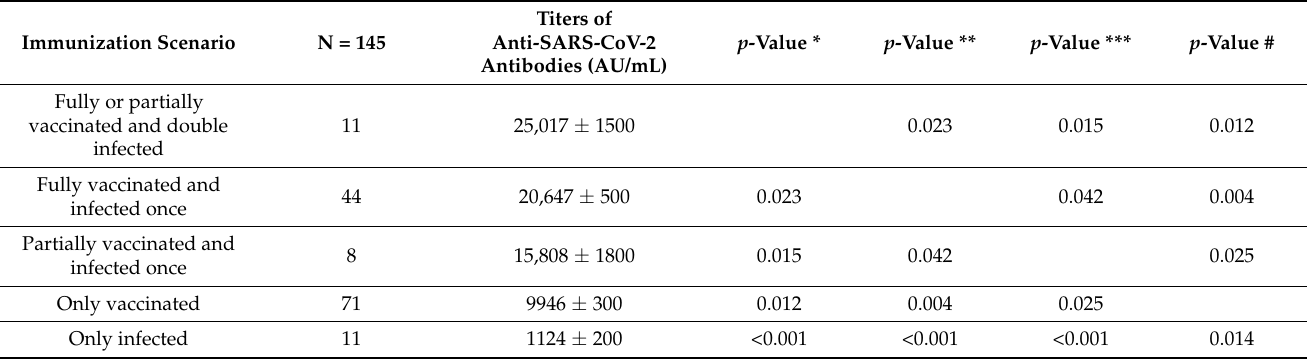
Table 2. Antibody response in different immunization scenarios during a year period in immuno- competent population (N = 145) and statistical analysis of different immunization